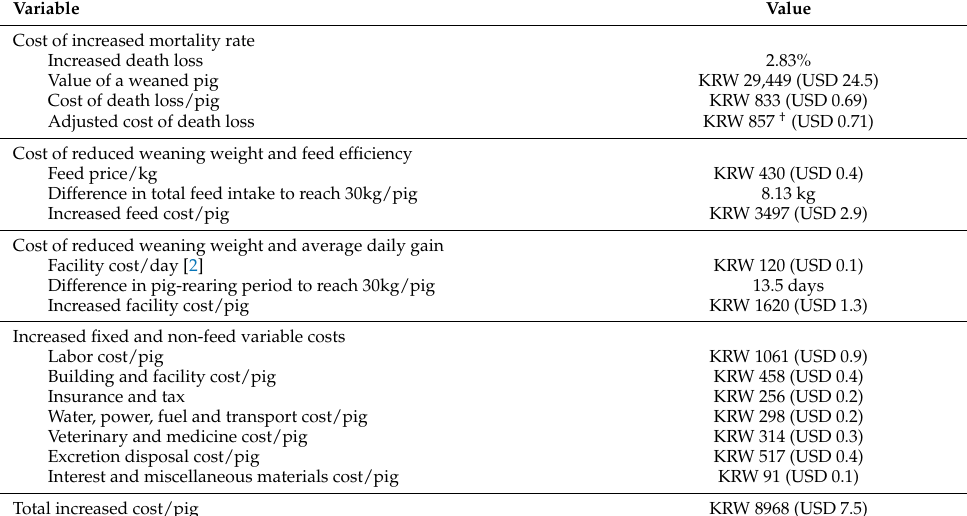
Table 4. The economic impact of PRRS on the nursery growth